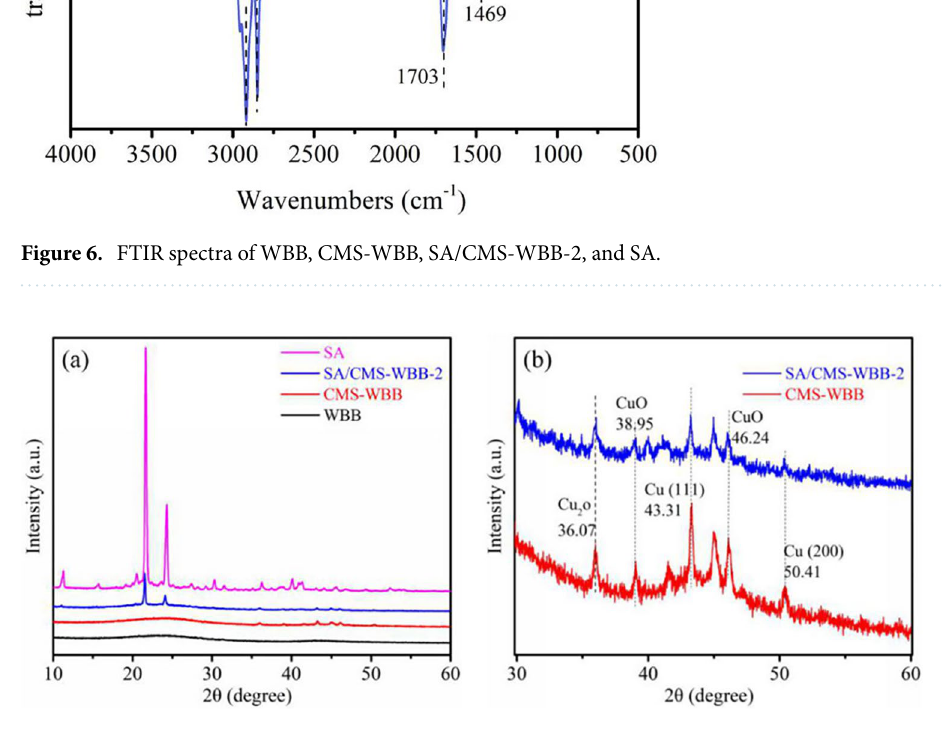
Figure 7. XRD patterns of SA, SA/CMS-WBB-2, CMS-WBB, WBB ( a ) and XRD patterns of SA/CMS-WBB-2 and CMS-WBB highlighted in range of 2θ = 30°–60° ( b